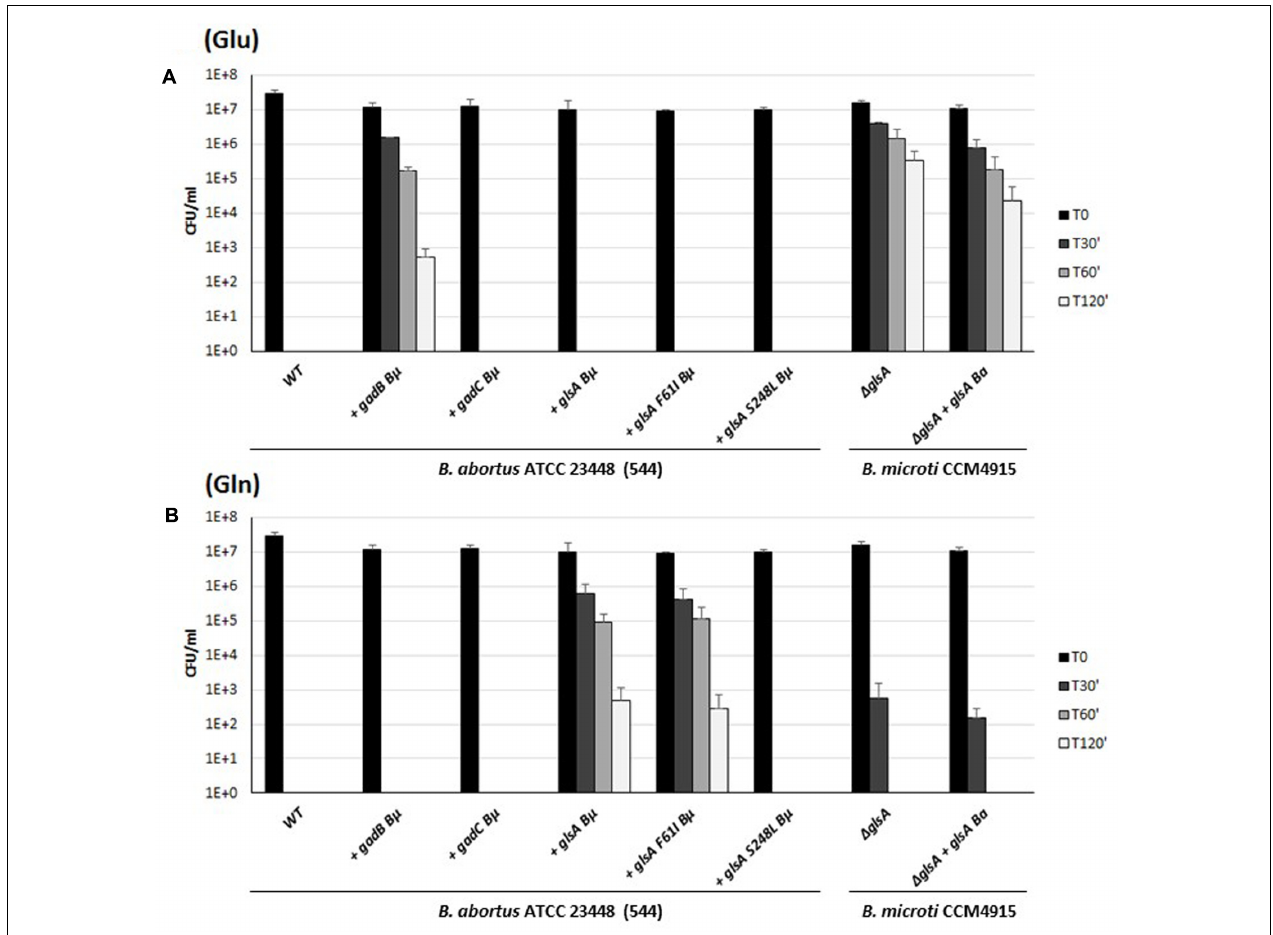
FIGURE 7 | Survival of wild-type, B. abortus ATCC 23448 and B. microti CCM4915 mutant and complemented strains during extreme acid exposure. Bacteria from stationary-phase cultures in TS at pH 7 and 5% CO 2 were harvested and incubated in a modified GMM at pH 2.5 supplemented with 3 mM of Glu (A) or Gln (B) . Heterologously complemented strains are marked with a “+” followed by the designation of the complementing gene, and the acronym of the donor species, i.e., B µ for B. microti and Ba for B. abortus . Two strains of B. abortus express in trans a modified version of the GlsA protein of B. microti with amino acid substitutions Phe61Ile or Ser248Leu. Residual viability following the acid shock was expressed as CFU/ml on a log10-scale at each time-point (T30, T60, and T120 min) and compared to unchallenged bacteria present at time T0 (GMM, pH 7.0). No viable bacteria were detected at the same time-points in the absence of Glu or Gln (data not shown). The data represent the mean (SD) of three independent